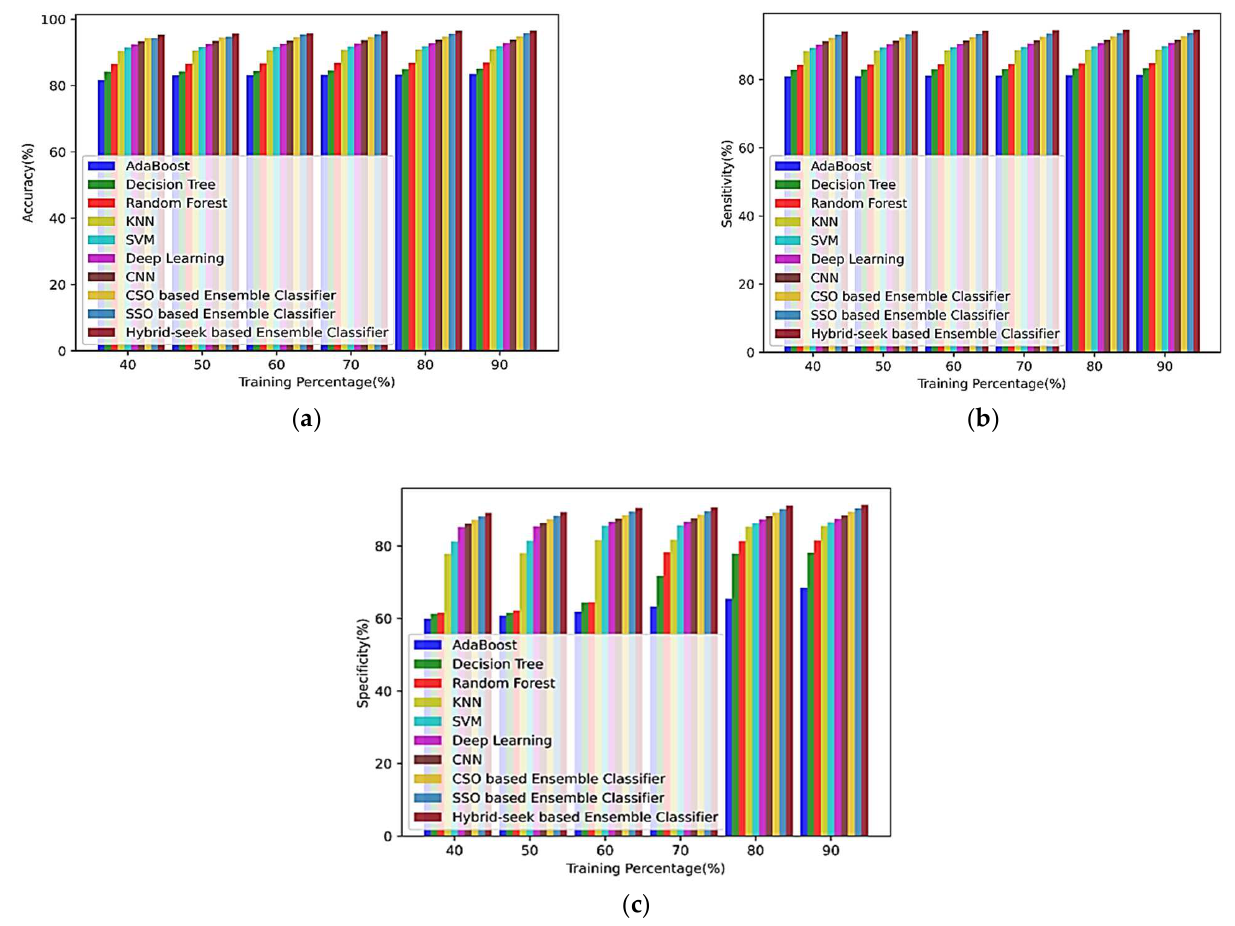
Figure 8. Comparison of the training % of the CHB-MIT database with other classifiers for ( a ) accuracy, ( b ) sensitivity, and ( c ) specificity.